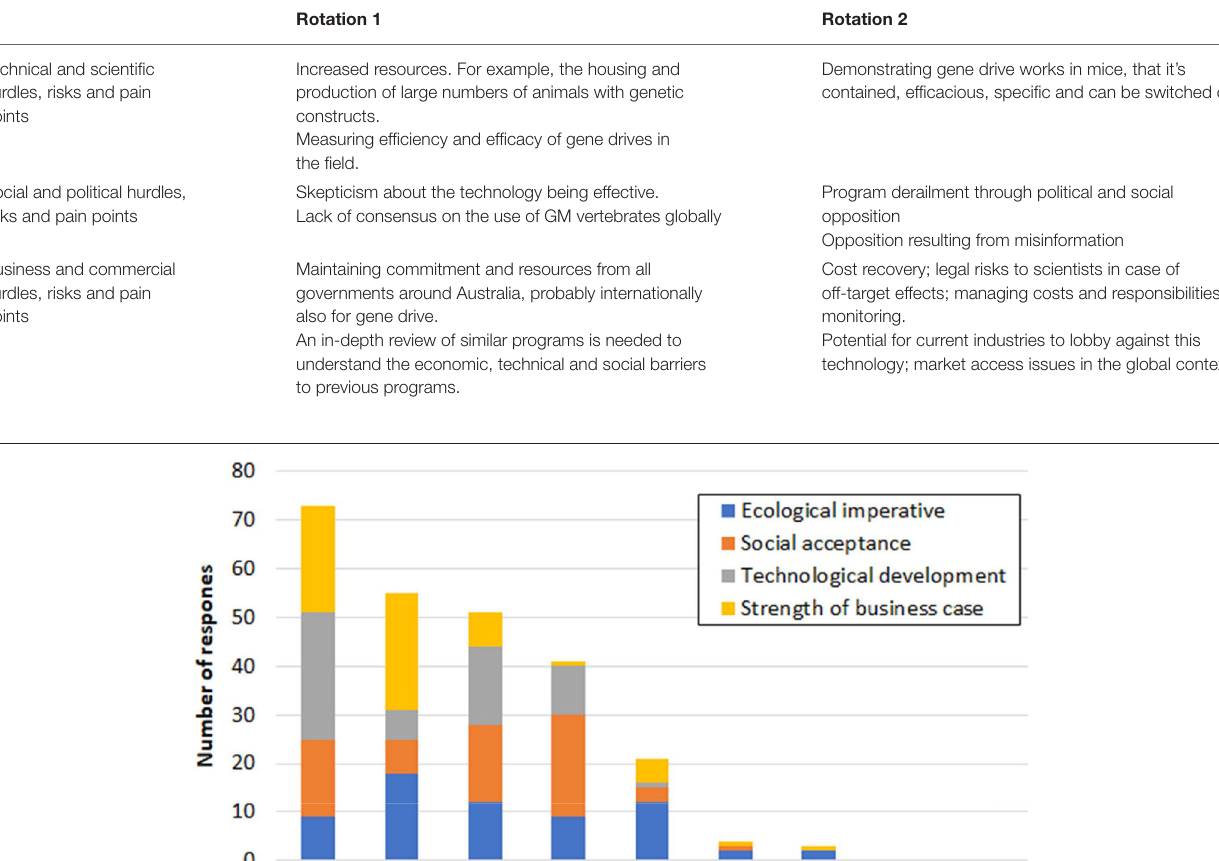
TABLE 2 | Identified commercial, social and technical hurdles to overcome before genetic control options could be implemented.